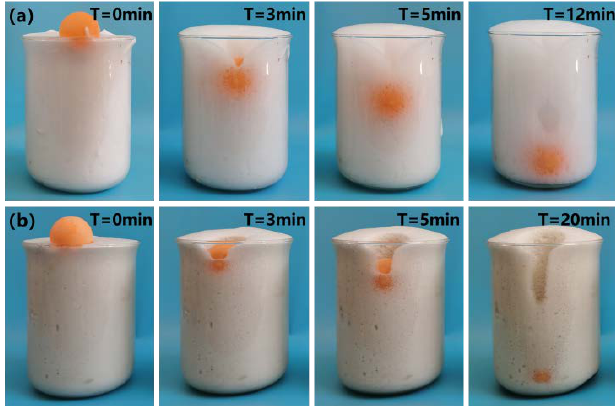
Figure 4. Foam stability test chart: ( a ) SF; ( b ) AF.